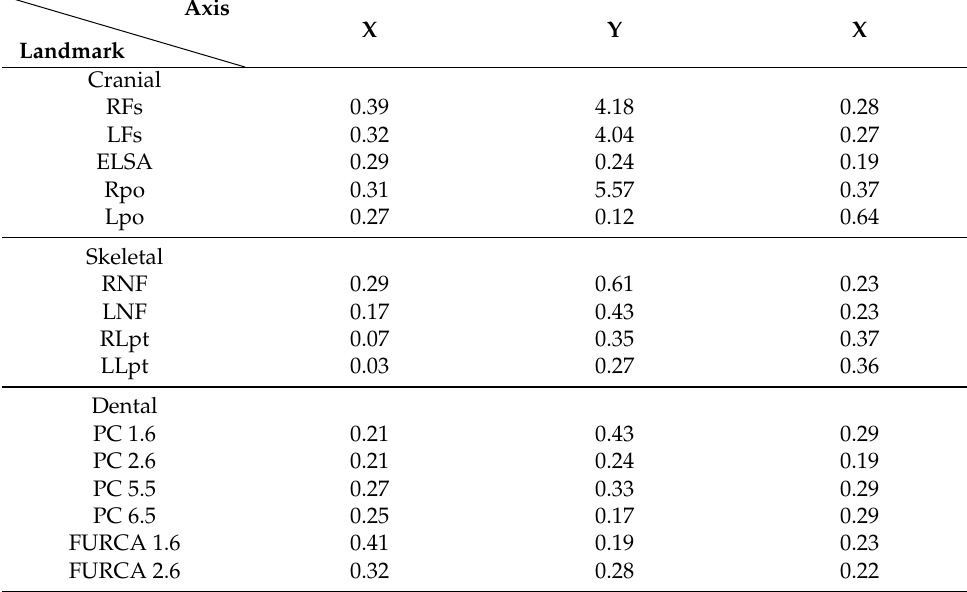
Table 3. Intraoperator error on x, y, and z axes.